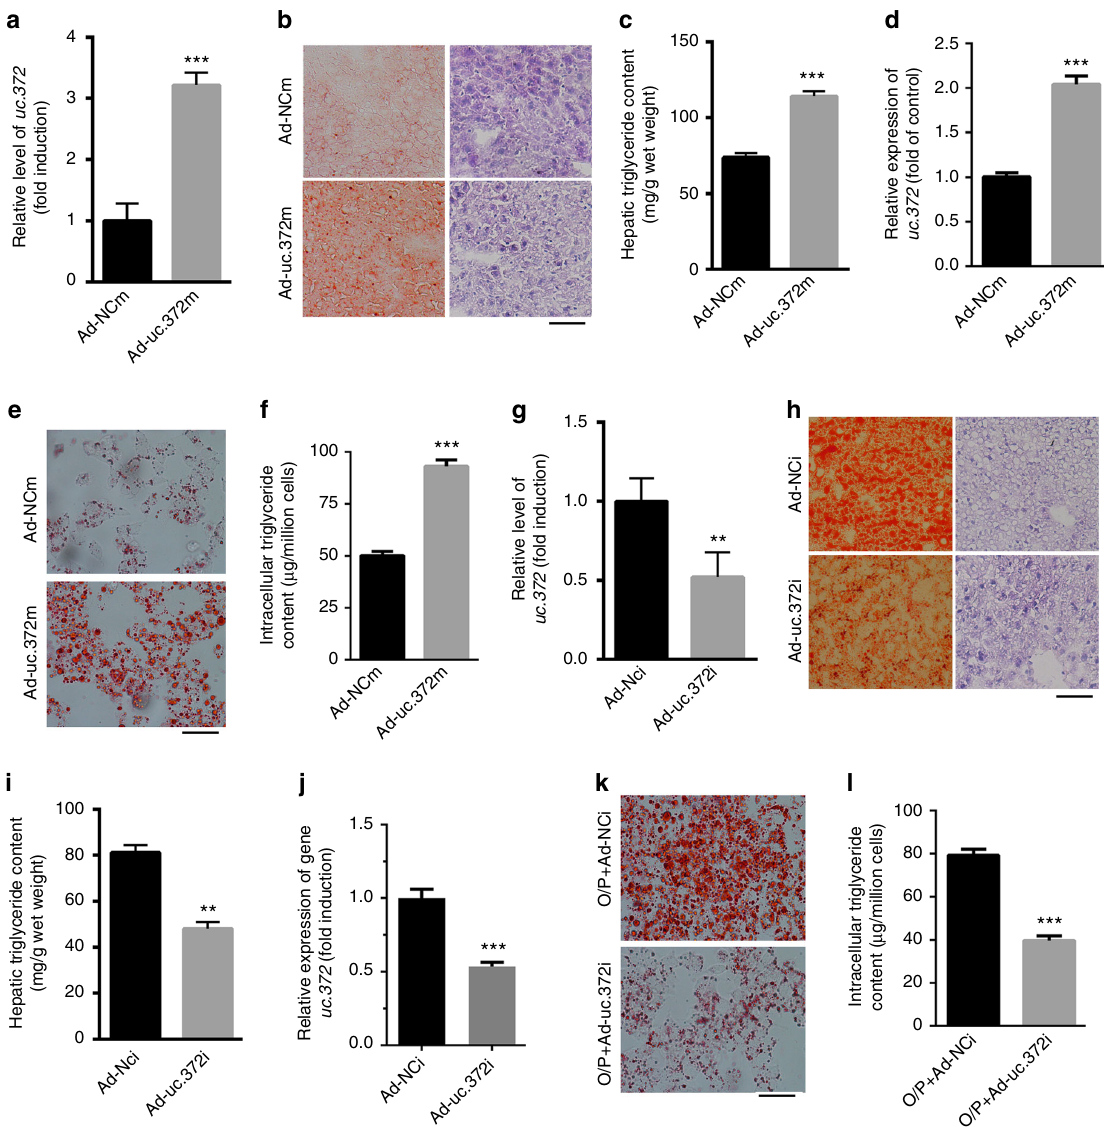
Fig. 2 Uc.372 drives hepatic lipid accumulation in mice. a Hepatic expression level of uc.372 in 6- to 8-week-old C57BL/6J mice administrated with Ad- uc.372m for 7 days by tail vein injection, as analyzed by real-time PCR ( n = 5). b Representative image from three similar experiments of H&E and Oil Red O staining in liver frozen sections of 6- to 8-week-old C57BL/6J mice after tail vein injection with Ad-uc.372 or Ad-NC for 7 days were shown. Scale bar, 400 μ m. c Hepatic triglyceride content in 6- to 8-week-old C57BL/6J mice after tail vein injection with Ad-uc.372 or Ad-NC for 7 days ( n = 5). d Expression level of uc.372 in HepG2 cells transfected with Ad-uc.372m or Ad-NC for 48 h ( n = 3). e Representative image from three similar experiments of Oil Red O staining in HepG2 cells transfected with Ad-uc.372m or Ad-NC for 48 h. Scale bar, 40 μ m. f Intracellular triglyceride content in HepG2 cells transfected with Ad-uc.372m or Ad-NC for 48 h ( n = 3). g Hepatic expression level of uc.372 in 10-week-HFD-fed mice administrated with Ad-uc.372i or Ad-NC for 7 days by tail vein injection ( n = 5). h Representative image from three similar experiments of H&E and Oil Red O staining in liver frozen sections of 10-week-HFD-fed mice after tail vein injection of Ad-uc.372i or Ad-NC for 7 days. Scale bar, 50 μ m. i Hepatic triglyceride content in 10-week-HFD-fed mice after tail vein injection of Ad-uc.372i or Ad-NC for 7 days ( n = 5). j Expression level of uc.372 in HepG2 cells transfected with Ad-uc.372i or Ad-NC for 48 h ( n = 3). k Representative image from three similar experiments of Oil Red O staining in HepG2 cells transfected with Ad-uc.372i or Ad-NC for 48 h. Scale bar, 40 μ m. l Intracellular triglyceride content in HepG2 cells transfected with Ad-uc.372i or Ad-NC for 48 h ( n = 3). Data are mean ± SEM; ** P < 0.01; *** P < 0.001 vs. control group ( a , c , g , i , j , l Student ’ s t